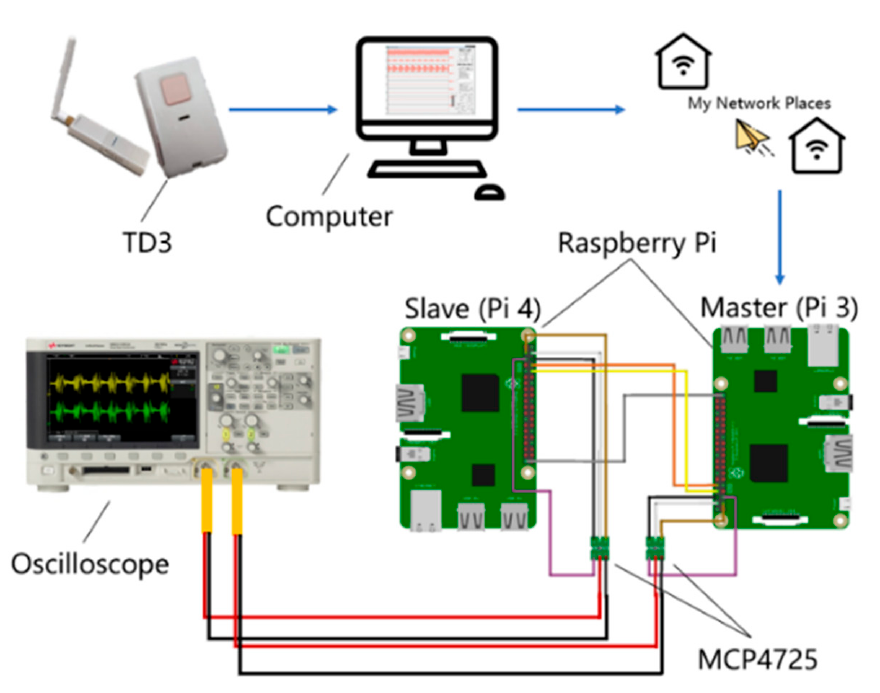
Figure 19. Architecture of the implementation.